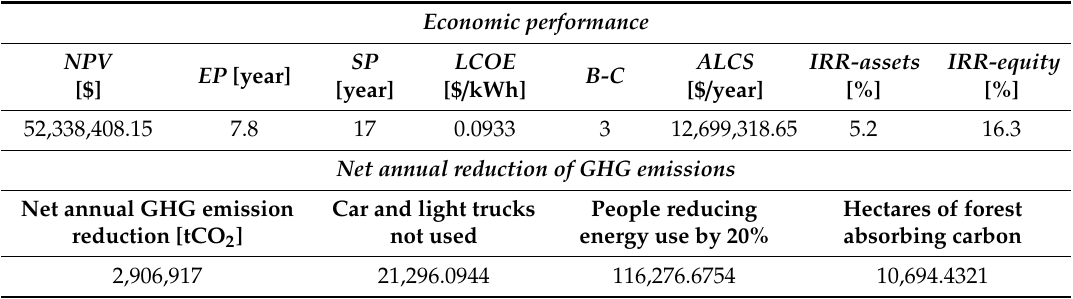
Table 10. Economic performance and net annual reduction of greenhouse gas (GHG) emissions.